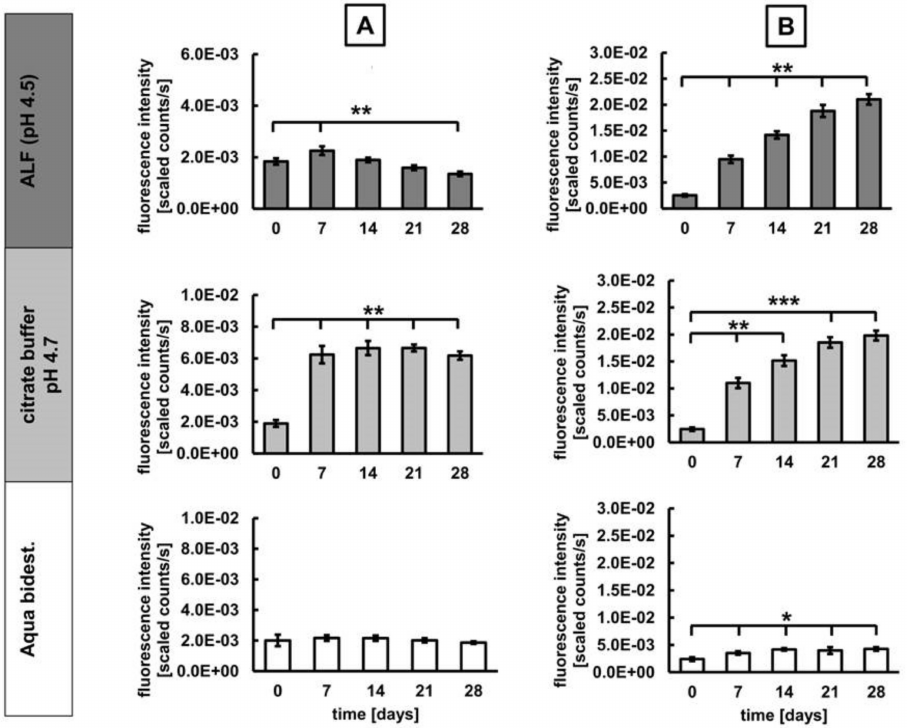
Figure 4. Fluorescence of DY-730 and DY-555 of the dually-labelled MNP-D(DY-730)-PEG-5kDa(DY-555) behave di ff erently in acidic conditions resembling lysosomes. ( A ) Fluorescence emission (755 nm) of DY-730 attached to the MNP core, ( B ) Fluorescence emission (573 nm) of DY-555 attached to the PEG-coating of the nanoparticles. MNP were suspended in 1% agarose in ddH 2 O and incubated at 37 ◦ C und 5% CO 2 for the period of time indicated, semiquantitative fluorescence analysis of ROIs (3346 pixels each), mean and standard deviation of the mean of n = 3, * p < 0.05; ** p < 0.01; *** p < 0.001.